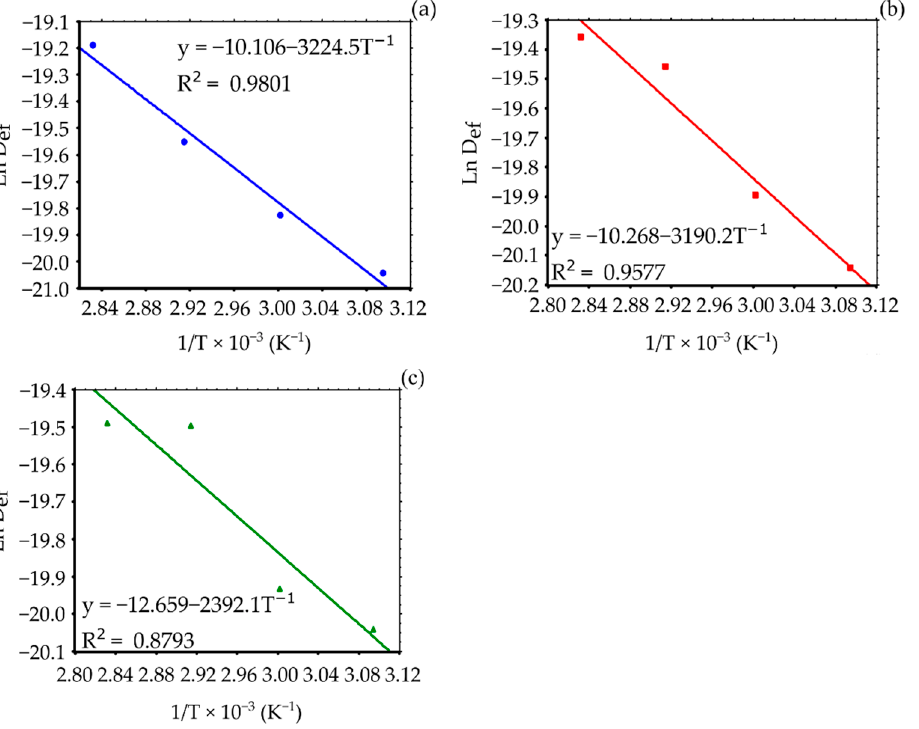
Figure 3. Arrhenius representation for the average effective diffusion coefficients obtained from drying germinated seeds of faba bean at temperatures of 50, 60, 70 and 80 °C for the varieties: ( a ) Orelha-de-Vó Preta; ( b ) Raio-de-Sol; and ( c ) Branca.